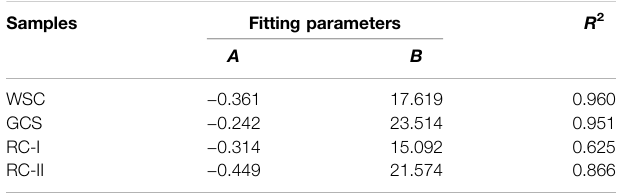
TABLE 4 | Fitting results for relationship between internal friction angle and water content. Samples